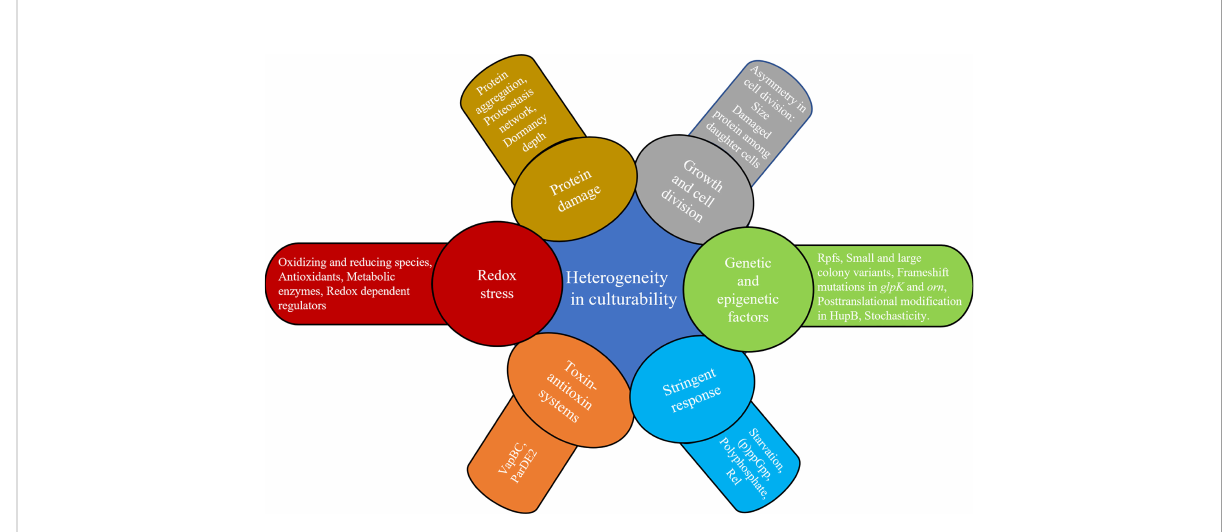
FIGURE 3 Factors that can introduce heterogeneity in